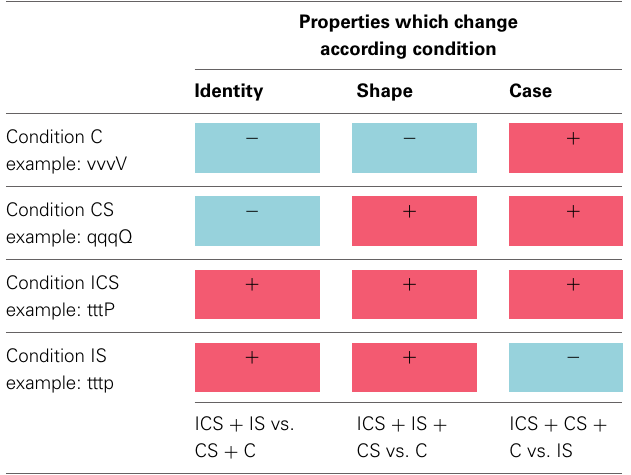
Table 1 | The four experimental stimulus conditions (C, CS, IS, and ICS) used in Change trials are depicted in the rows, and each representational dimension investigated (identity, shape, and case) are depicted in the